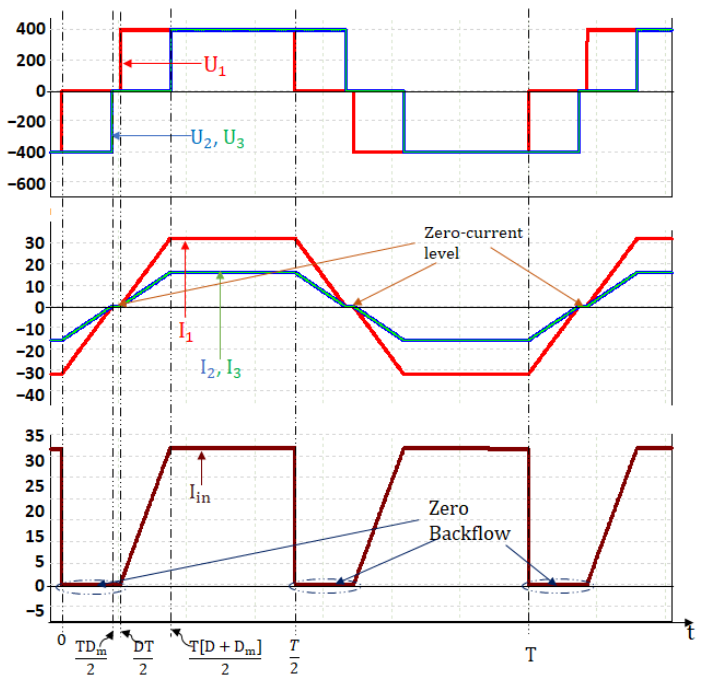
Figure 5. Voltage and current waveforms when 𝐷 = 𝐷 𝑚 .